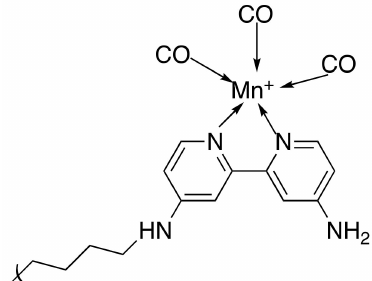
Figure 6. A representation of the DABPY / PEG coating on the MOF surface chelating to Mn carbonyl, the CO source.